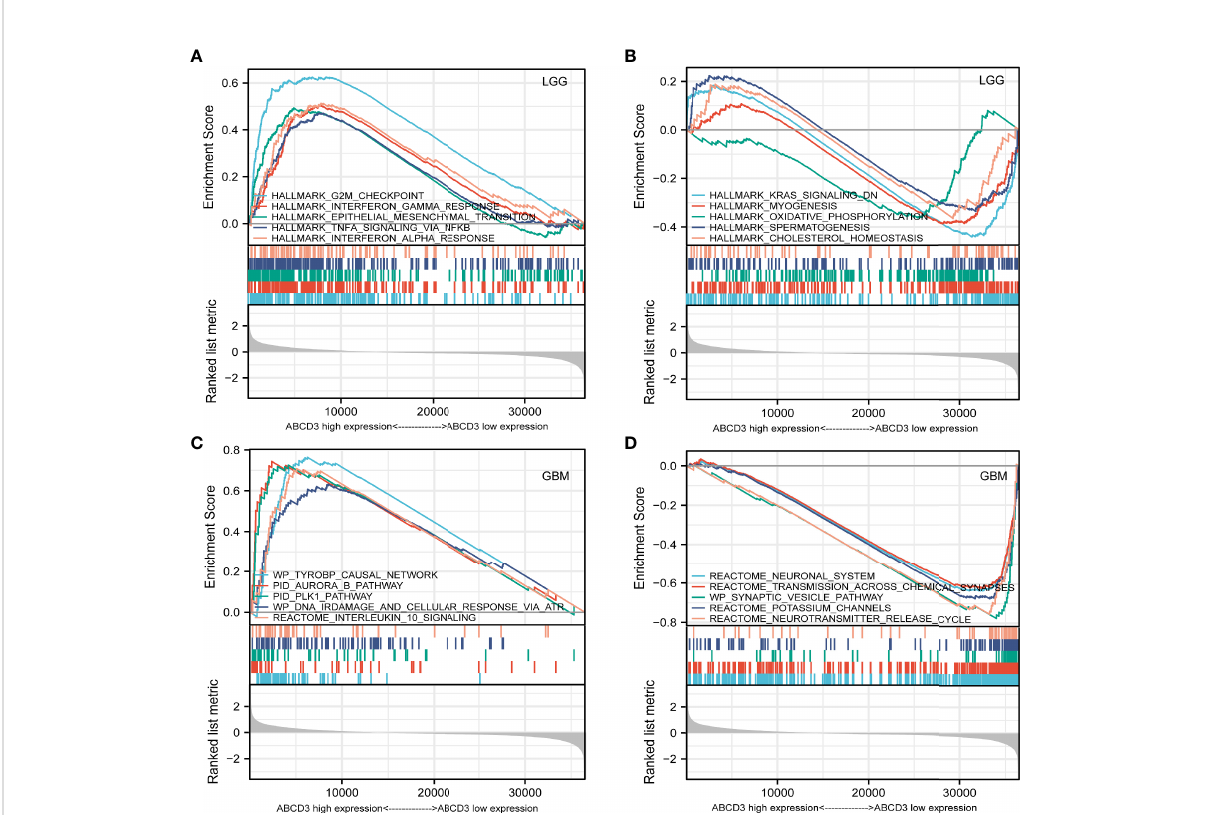
FIGURE 6 GSEA analysis of LGG or GBM samples with high or low ABCD3 expression phenotype. (A) GSEA results showing the top 5 enriched gene sets in the LGG samples with high ABCD3 expression based on NES. (B) GSEA results showing the top 5 enriched gene sets in the LGG samples with low ABCD3 expression based on NES. (C) GSEA results showing the top 5 enriched gene sets in the GBM samples with high ABCD3 expression based on NES. (D) GSEA results showing the top 5 enriched gene sets in the GBM samples with low ABCD3 expression based on